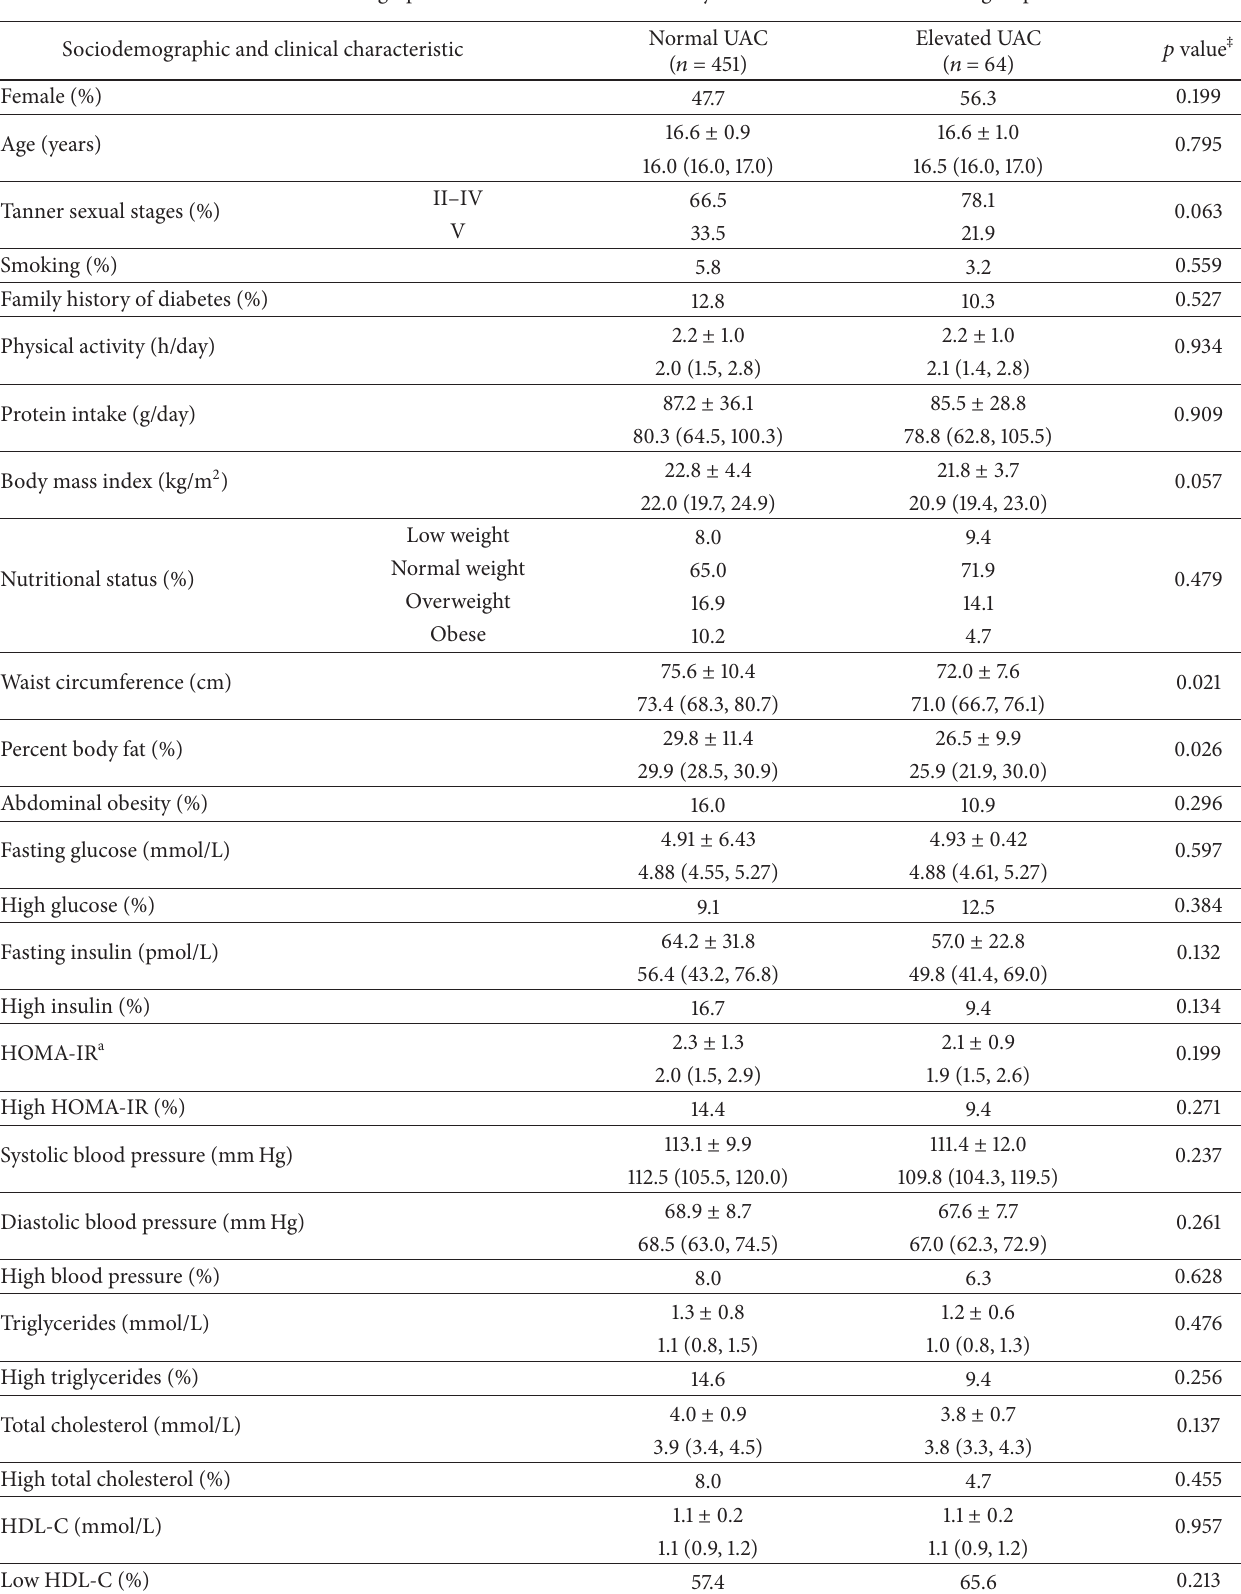
Table 1: Sociodemographic and clinical characteristics by urine albumin concentration